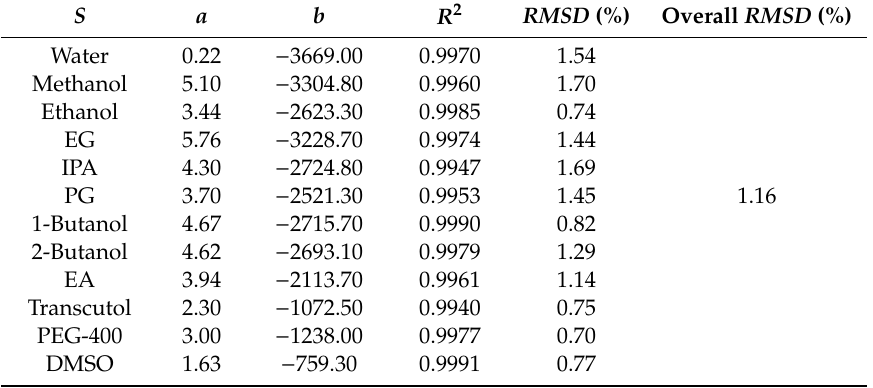
Table 4. The van’t Ho ff model parameters ( a and b ), R 2 and RMSD (%) for PPD in various neat solvents ( S